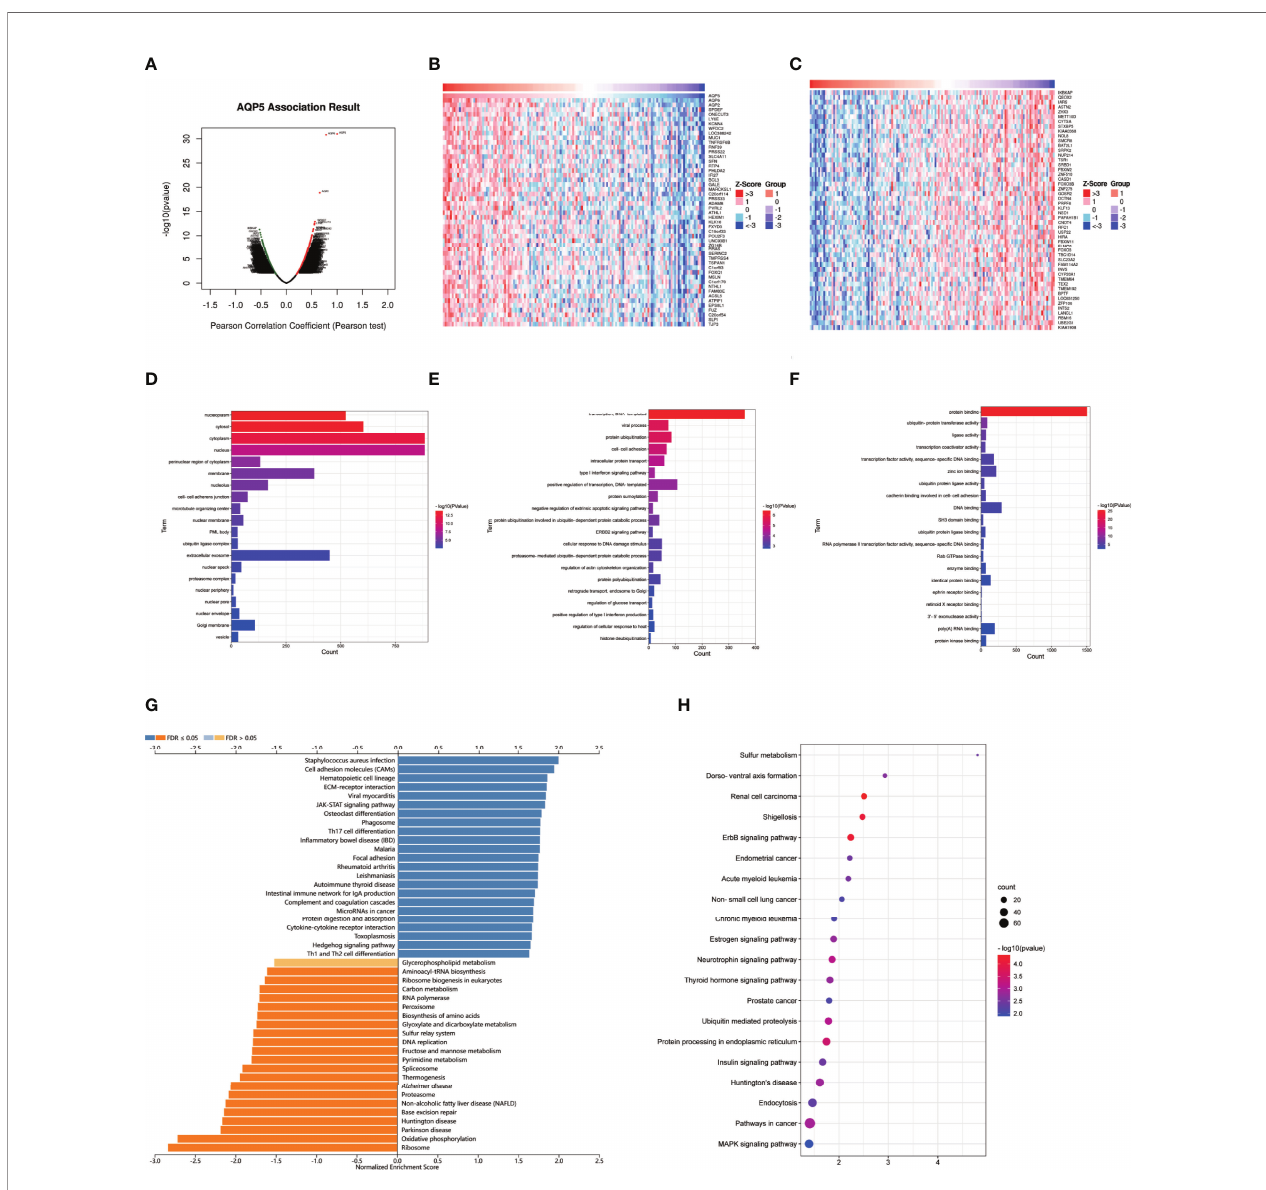
FIGURE 7 | AQP5 co-expressed gene and functional enrichment analysis in PAAD. (A) The volcano map of AQP5 gene co-expression. (B, C) The heatmap of the top 50 positive and negative AQP5 gene co-expression. (D – F) The GO analysis of AQP5 gene co-expression in molecular function (MF), cellular component (CC), and biological process (BP). (G) AQP5 co-expression genes were annotated by Gene Ontology (GO) analysis. (H) The top 20 KEGG pathway analysis of AQP5 gene